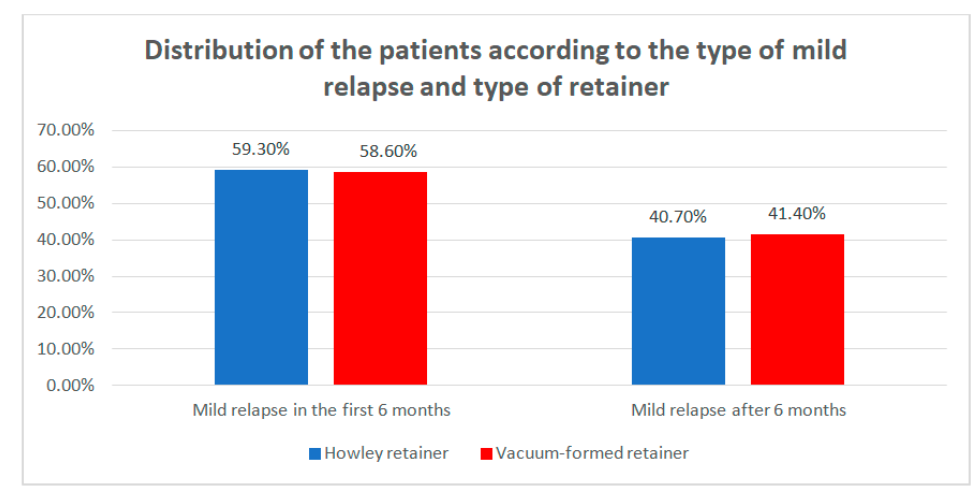
Figure 10. Distribution of the patients according to the type of mild relapse and type of retainer.